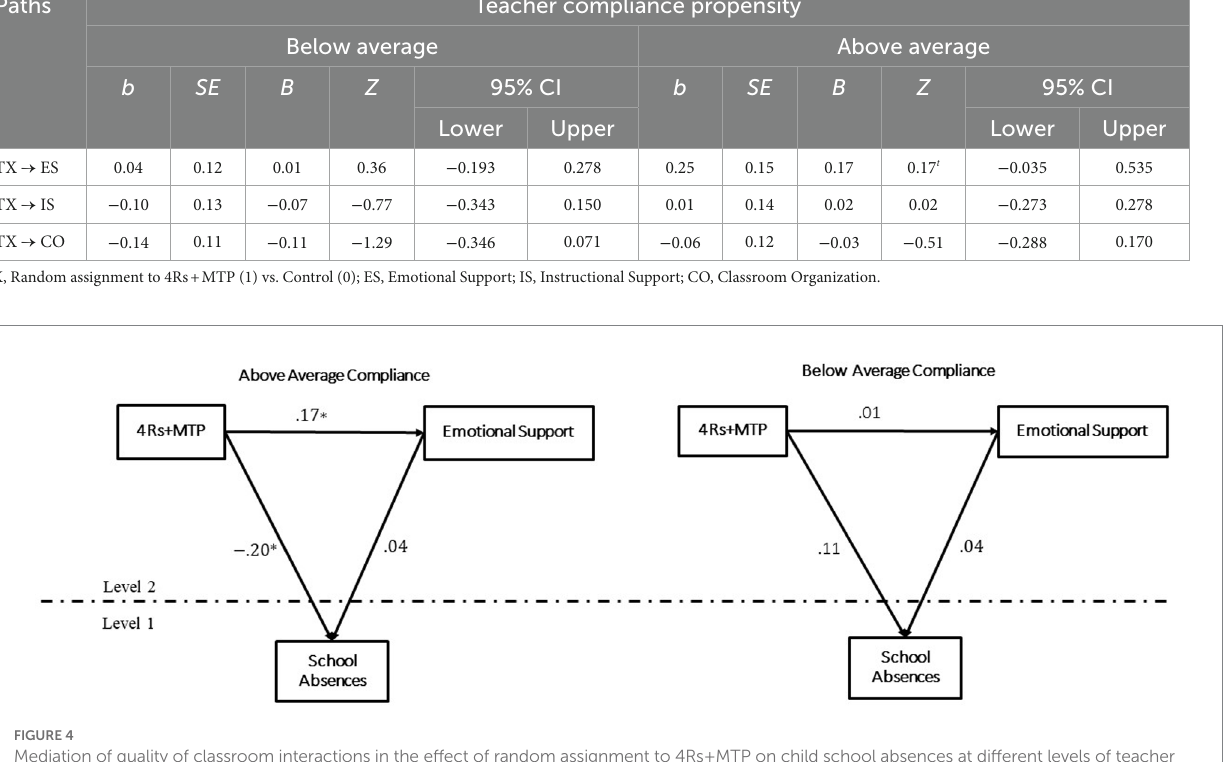
TABLE 8 Effects of 4Rs + MTP on quality of classroom interactions conditioned on teacher compliance propensity (Path “a”). Paths